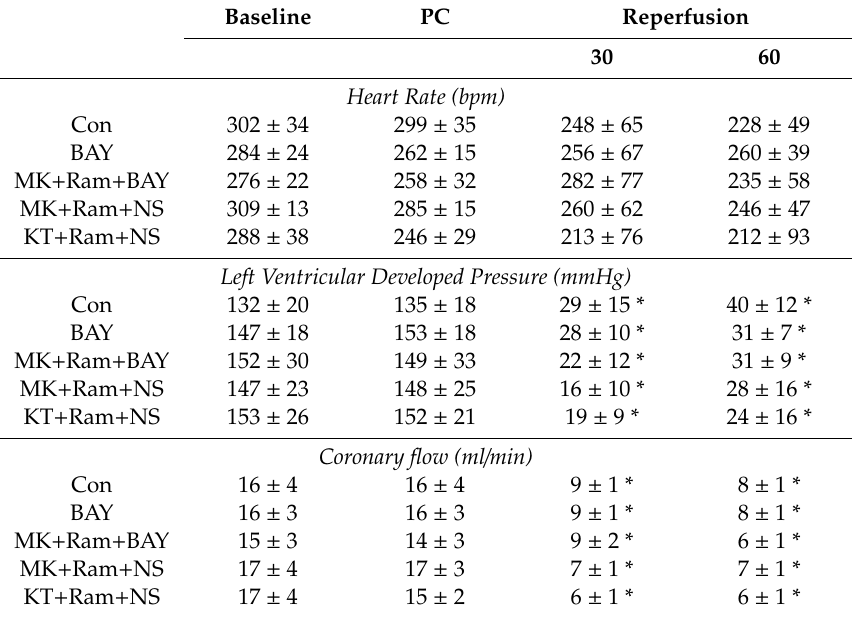
Table 3. Hemodynamic